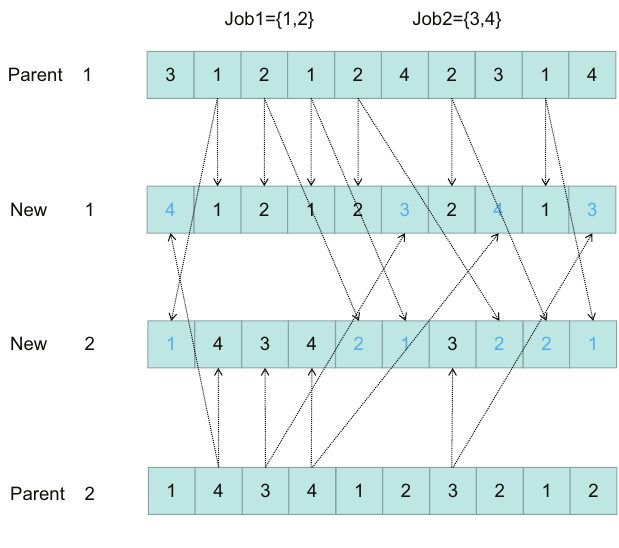
Figure 4. POX crossover.